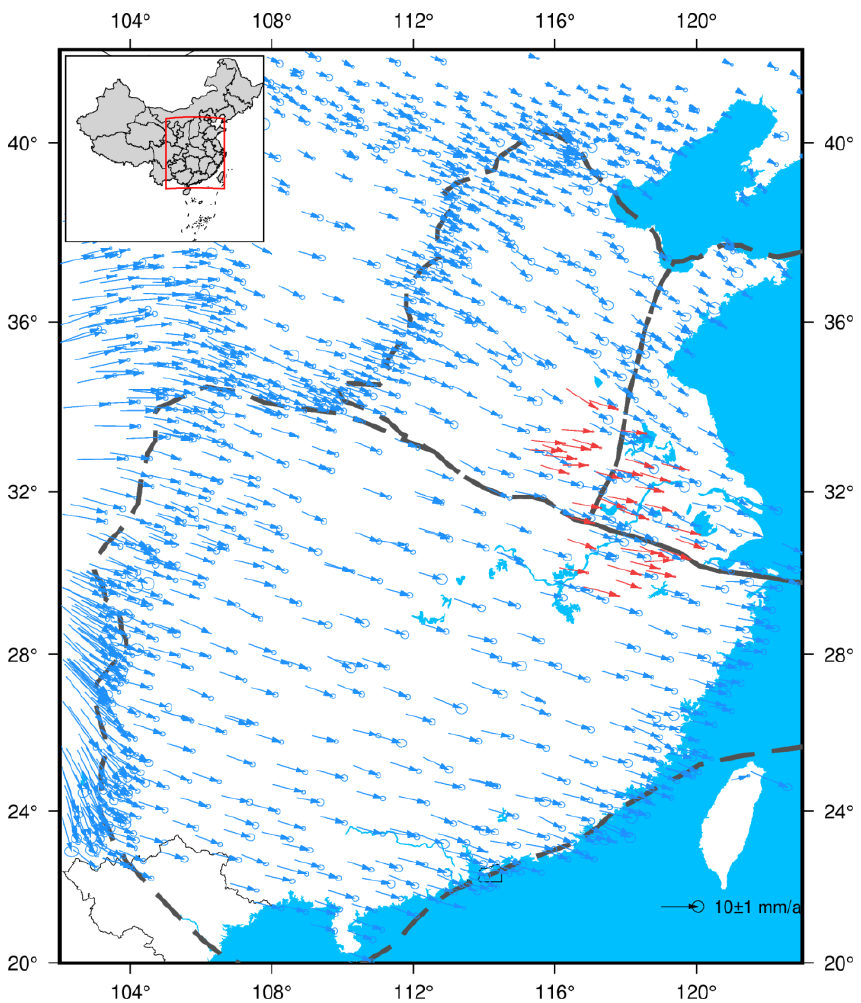
Figure 2. GPS velocity field with respect to Eurasian plate. Blue and red arrows represent the velocity field of CMONOC and AHCORS, respectively. The areas surrounded by dashed line are North China block, Ludong block, and South China block. Error ellipses represent 70% confidence.